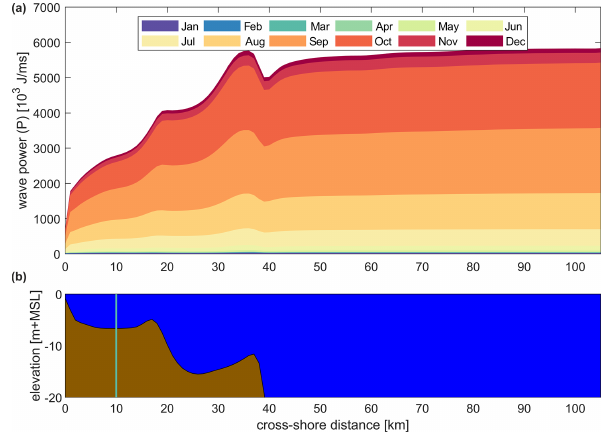
Figure 14. Median over 41 years of monthly cumulative wave power ( P ) along a transect (see Fig. 4) from nearshore (left) to off- shore (right). Different colors represent different months and are cu- mulative (a) . Associated bathymetry and water depth (MSL: mean sea level) (b) . The green line in the lower panel marks the location of the Liberty Prospect